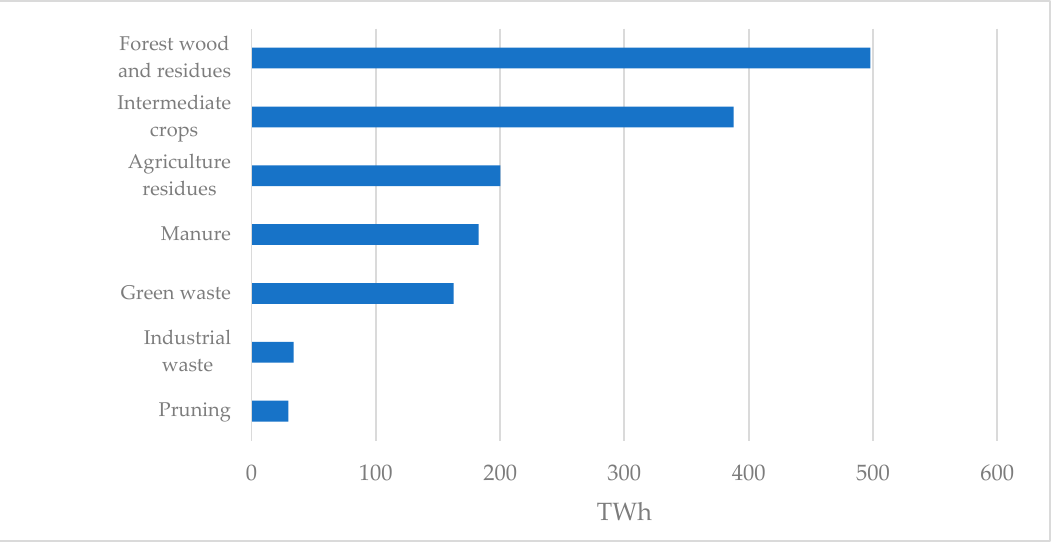
Figure 10. The theoretical potential of biomethane production (TWh) from various categories of biomass in EU and UK in perspective 2050. Source: own elaboration based on Birman et al.